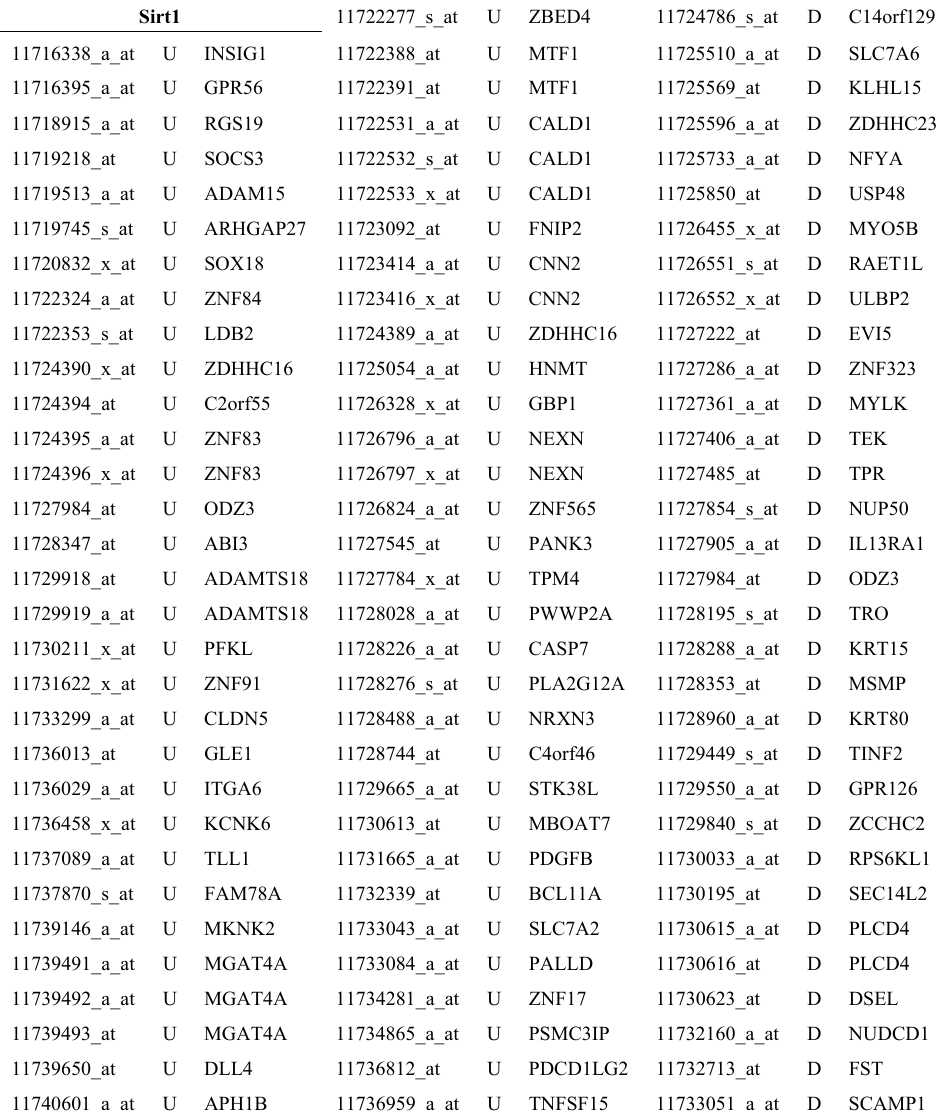
Table 1. List of differentially expressed genes after Sirt1 or Sirt2 gene silencing (read the entire table